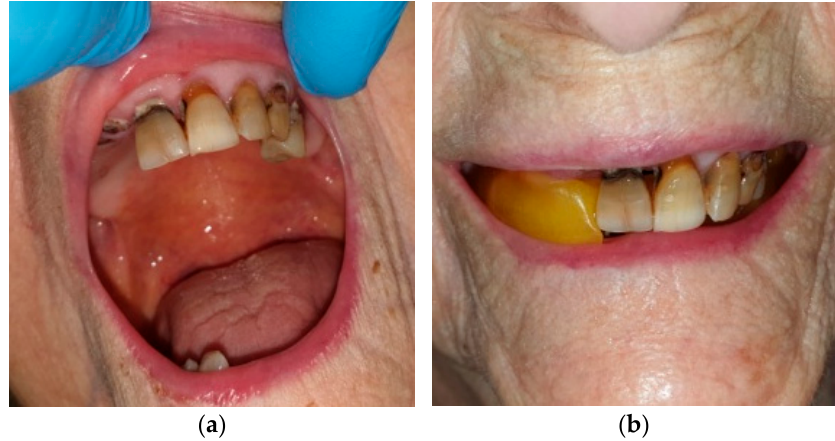
Figure 4. ( a ) Initial situation in a 99-year-old patient; ( b ) vertical-dimension registration phase.